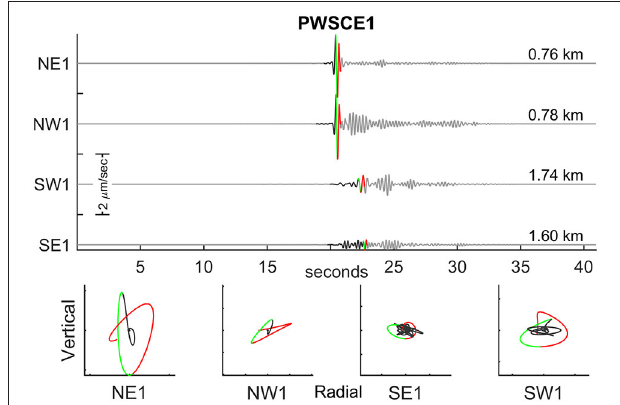
FIGURE 12 | The top portion of the figure shows the vertical traces of the phase-weighted stack for event cluster 1 at four stations (distances are from station to summit vent) with the P and possible SV wave arrivals highlighted in solid black, the green and the red highlight the down going swing and following cycle of the dominant Rayleigh wave, while the bottom of the figure shows polar plots of particle motion normalized to the maximum amplitude of each trace at each station, showing the retrograde